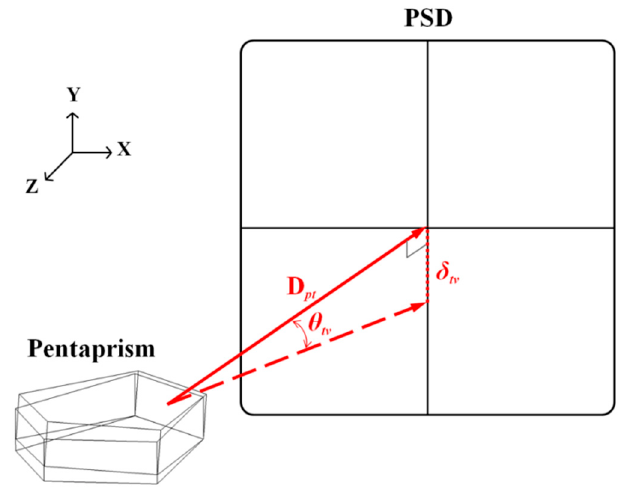
Figure 11. Vertical setup error of the pentaprism.